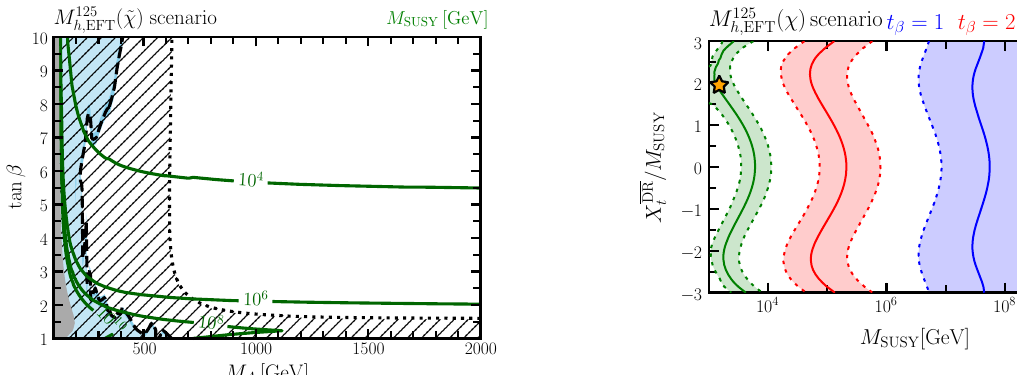
Fig. 5 Contour lines of M h (cid:7) 125GeV ( solid ) and M h (cid:7) 122 , 128GeV ( dashed ) as a function of M SUSY and X DR t / M SUSY ) , for , tan β) A tan β = 1 ( blue ), tan β = 2 . 5 ( red ) and tan β = 10 ( green ). M A is fixed to 1TeV. All remaining parameters are as in the M 125 nario. The orange star marks the approximate position of the M 125 scenario